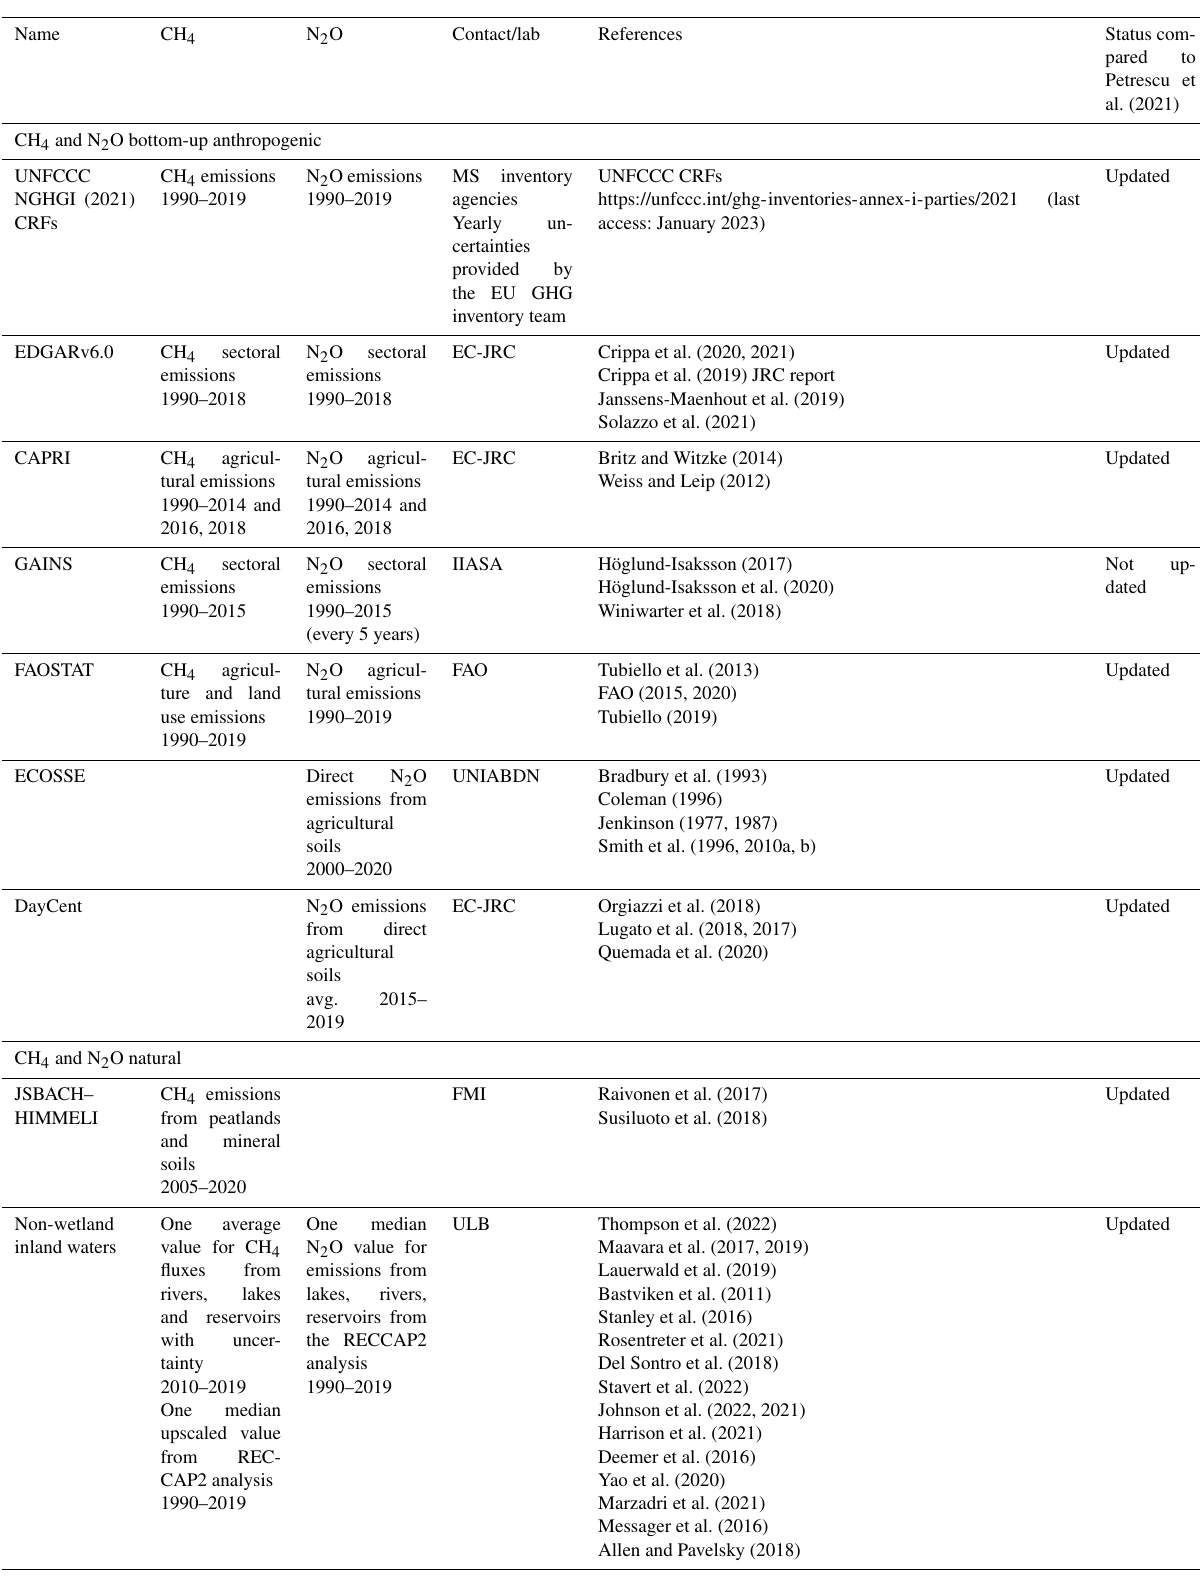
Table 2. Data sources for CH 4 and N 2 O emissions used in this